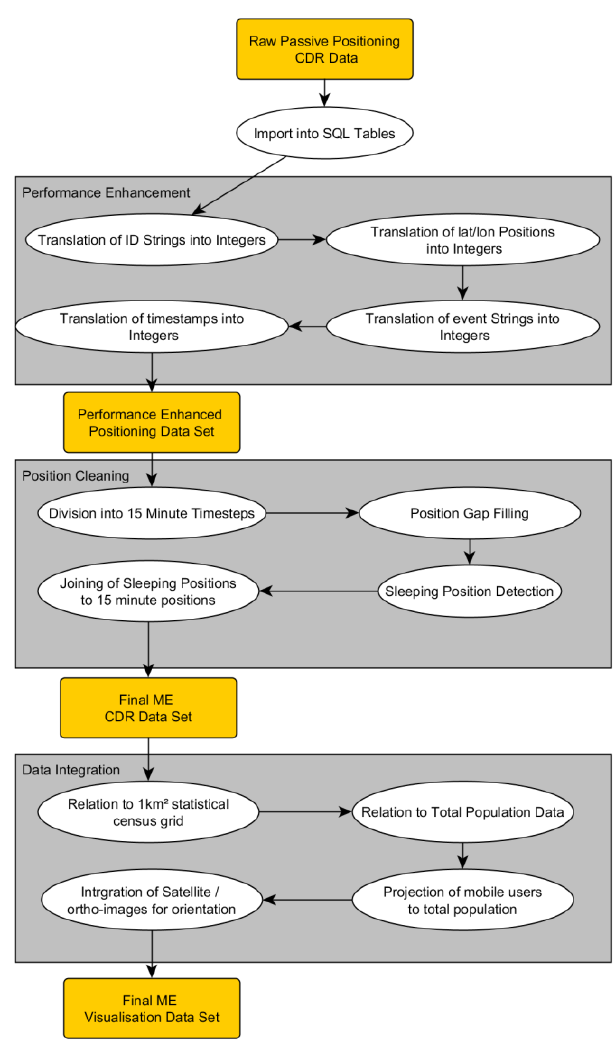
Figure 4. Processing steps: from raw CDR data to the dynamic visualisation dataset.